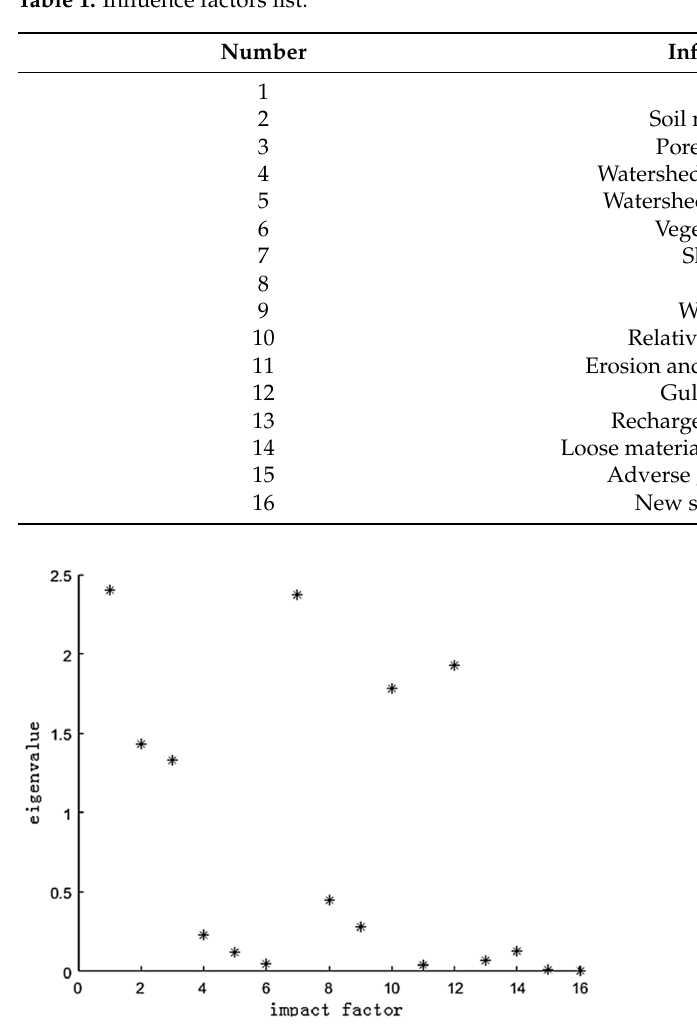
Figure 7. Eigenvalue of influence factor.